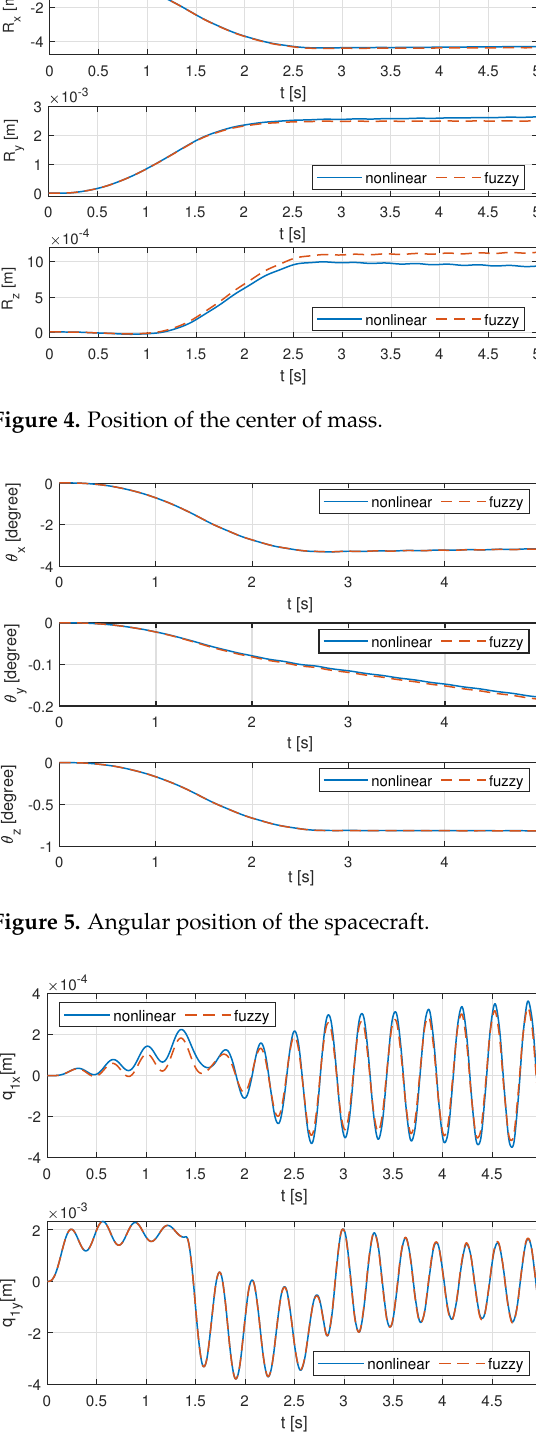
Figure 6. Appendage 1